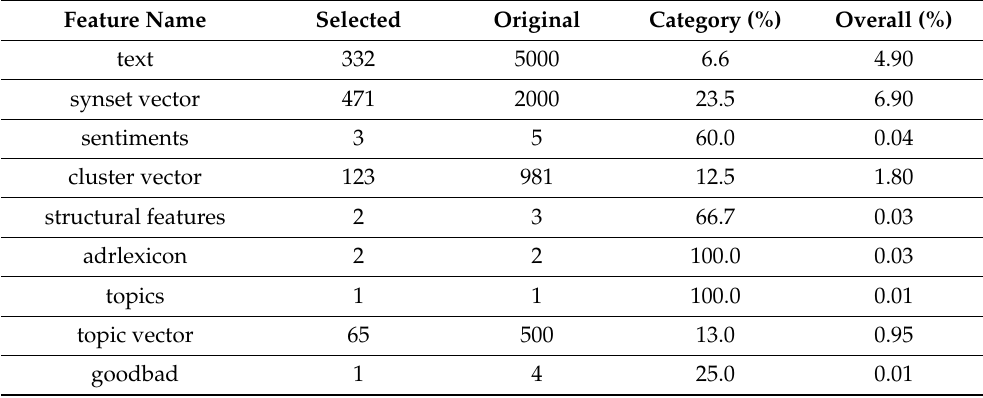
Table 7. Results of the different types of features